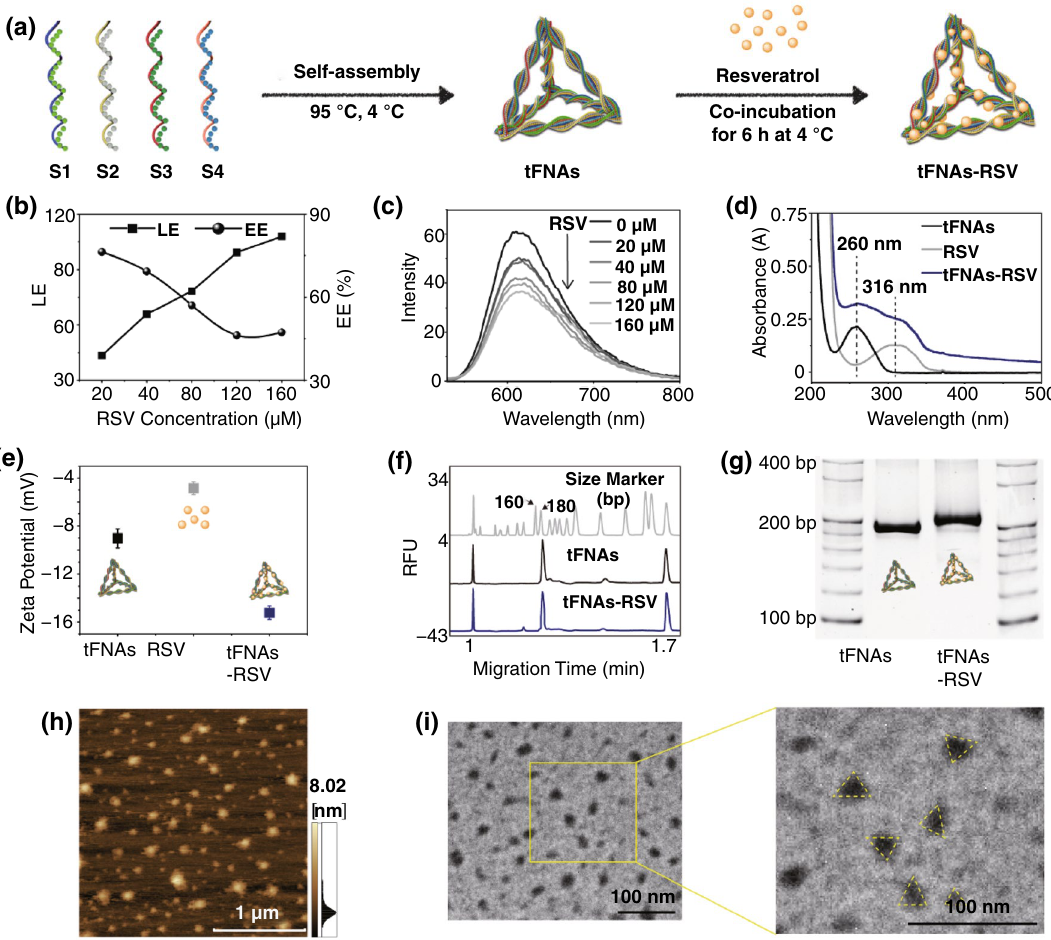
Fig. 1 Synthesis and characterization of tFNAs-RSV. a Schematic of the synthesis of tFNAs and the preparation of tFNAs-RSV; b LE and EE of RSV into tFNAs; c fluorescence emission spectra of Gel-Red (λex = 312 nm) in the presence of different concentrations of RSV (20–160 μM) in 250 nM tFNAs; d spectra of tFNAs, RSV, and tFNAs-RSV between 200 and 500 nm; e zeta potential of tFNAs, RSV, and tFNAs-RSV; f synthesis of tFNAs and tFNAs-RSV determined by high-performance capillary electrophoresis; g PAGE verifies the successful generation of the nanoparticles; h AFM images of tFNAs-RSV. Scale bar: 1 μm; (i) TEM images of tFNAs-RSV. Scale bar: 100